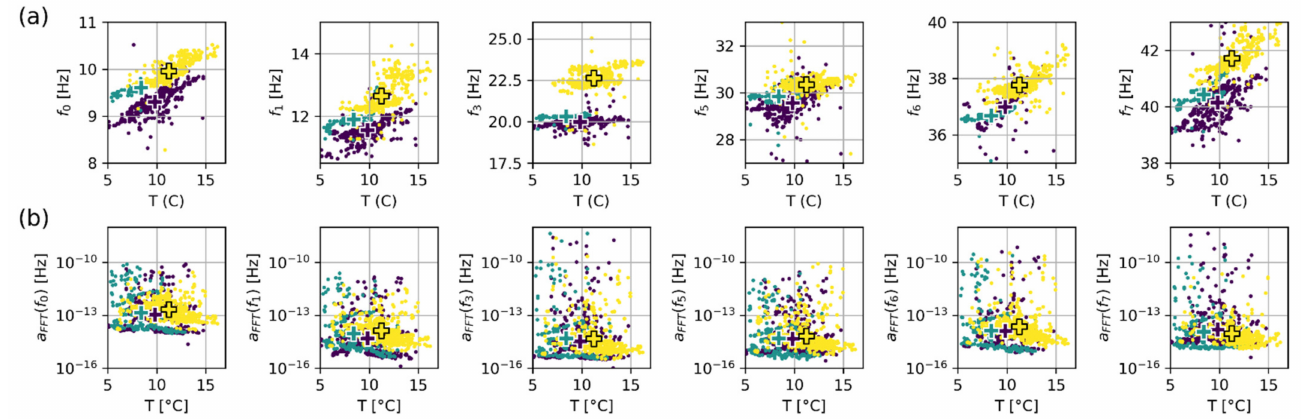
Figure 10. FFT peak frequencies f n ( a ) and corresponding peak amplitudes a FFT ( f n ) ( b ) as a function of air temperature. Initial stage before bolting is shown with dark blue dots. Stage between i 1 and i 2 is shown in green. Final stage after i 2 is shown with yellow dots. Centroid of each phase is pointed with a colored cross. Days with drilling works have been removed from the dataset.